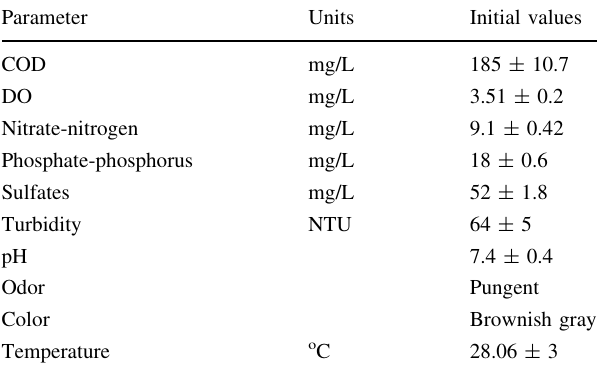
Table 1 Raw wastewater parameters before treatment